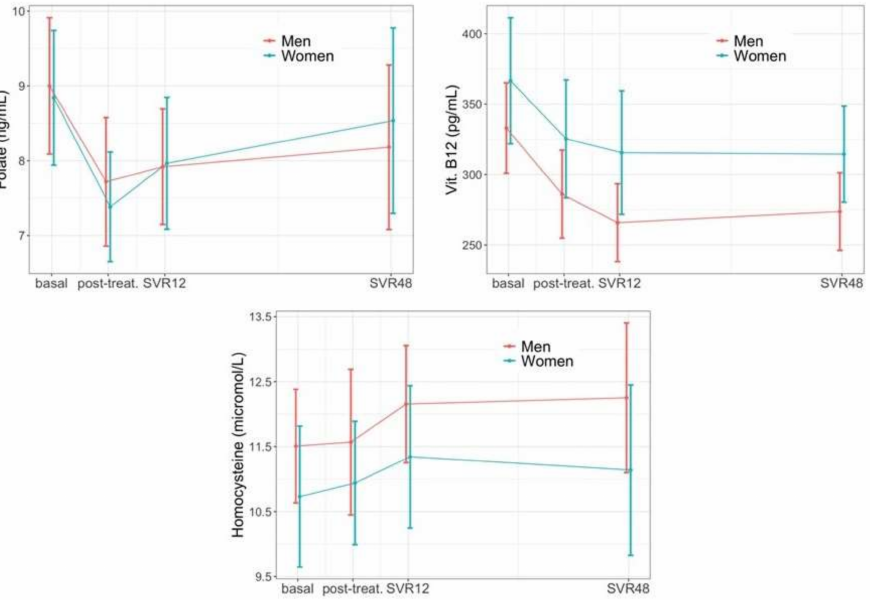
Figure 5. Vitamine B12, folate and homocysteine changes during follow-up. Next, we sought to evaluate the effects of DAA on coagulation changes in our cohort. The international normalized ratio (INR), partial thromboplastin time (PTT), prothrombin activity (PA), and derived fibrinogen changed significantly during the follow-up for the en- tire cohort (all p long < 0.001); however, those changes occurred at different times